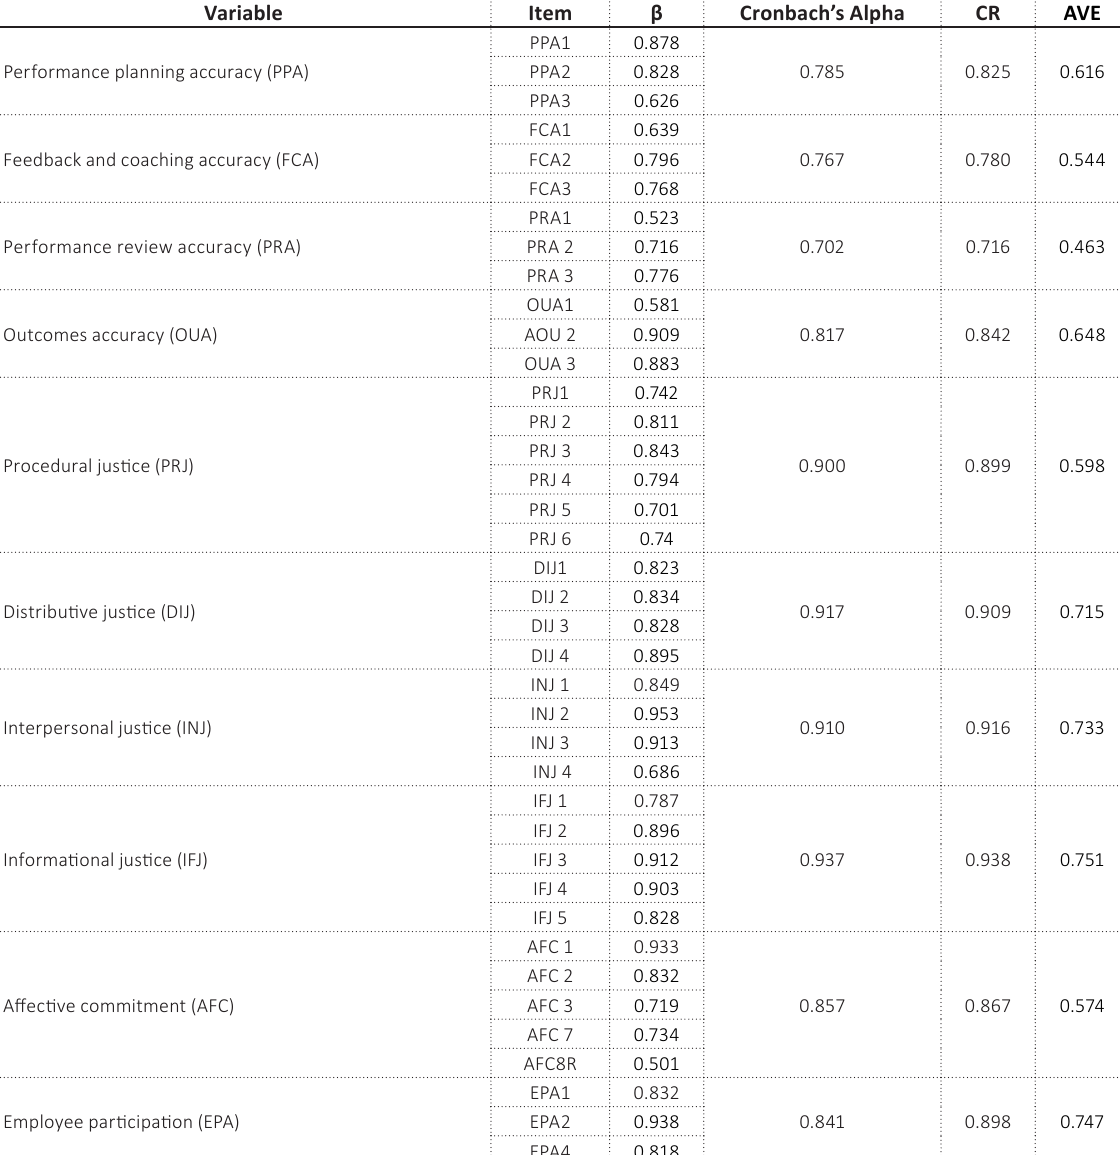
Table 2. Convergent validity and internal consistency